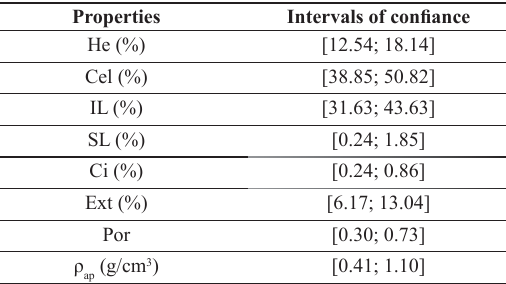
Table 4. Intervals of the values in the independent variables utilized in the regression models.